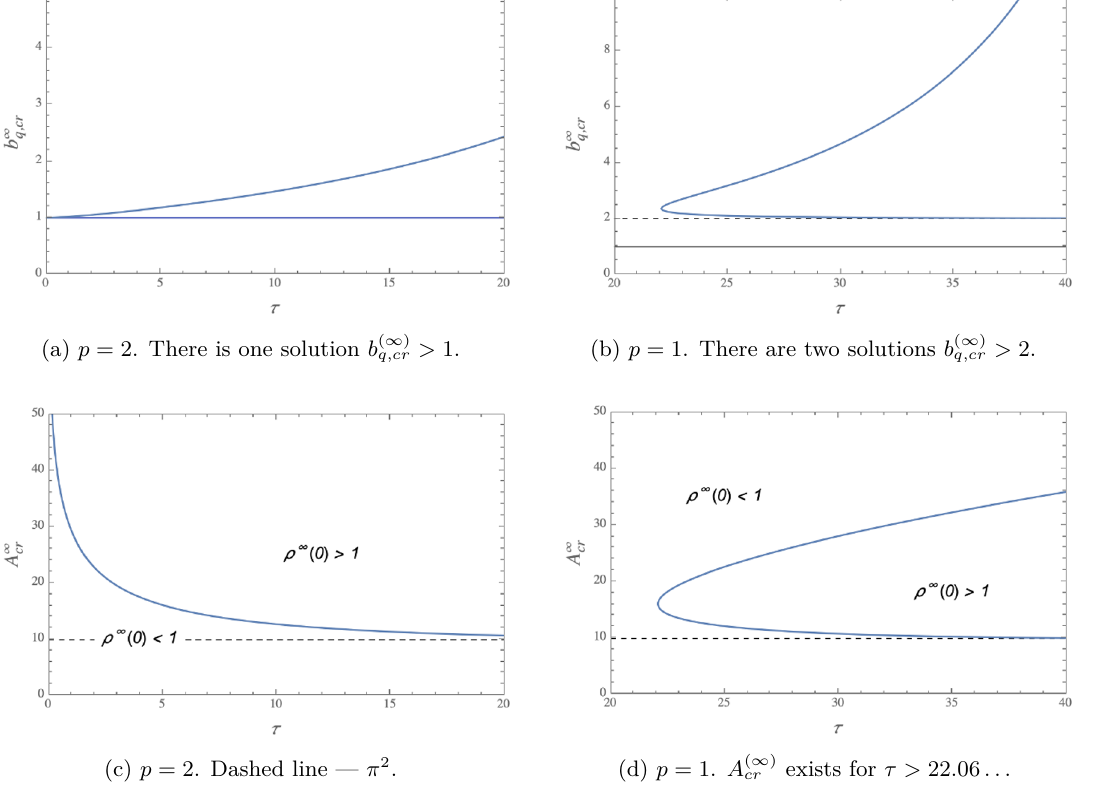
(cid:0) (cid:1) A, p, 0 > 1